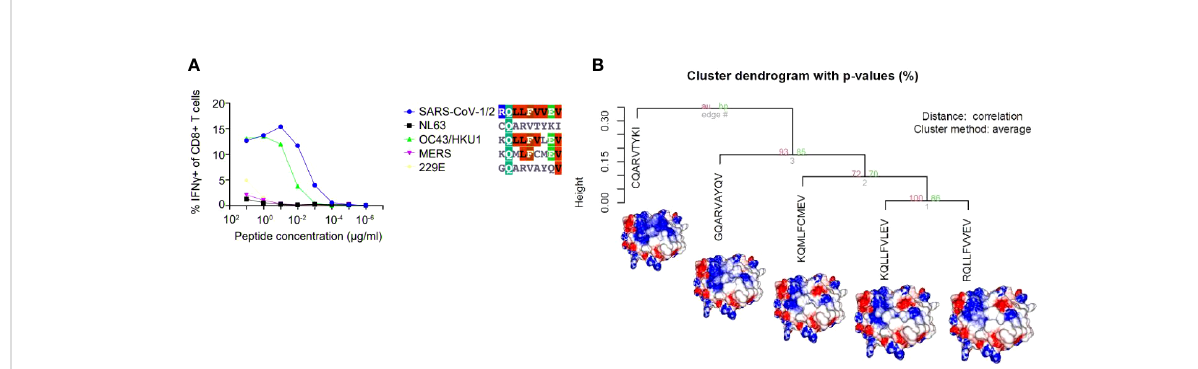
FIGURE 5 A hierarchical clusterization of pMHC ’ s electrostatic surfaces of different epitope sequences belonging to distinct coronaviruses (SARS-CoV-½, NL63, OC43/HKU1, MERS, 229E). In the chosen example, fi ve sequences (in the context of HLA-A*02:01) from the analysed coronavirus were challenged against the same TCR and presented the pattern of recognition showed in (A) . In (B) , we depicted the HCA and images from the customized pMHC model complexes demonstrating that the epitopes that elicited the cross-reactive response were the most similar (from OC43/HKU-1 and SARS-CoV-1/2), providing an explanation for the observed pattern of cross-reaction. The fi gure presenting the results in A was extracted, and modi fi ed from